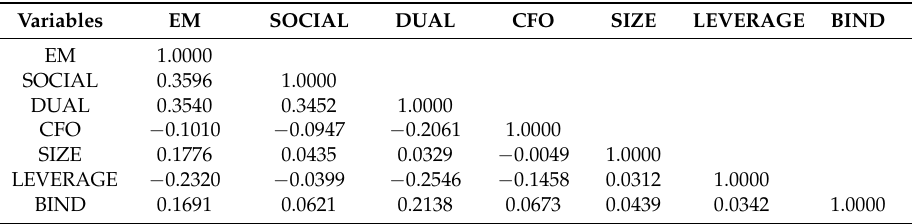
Table 3. Correlations among Variables.